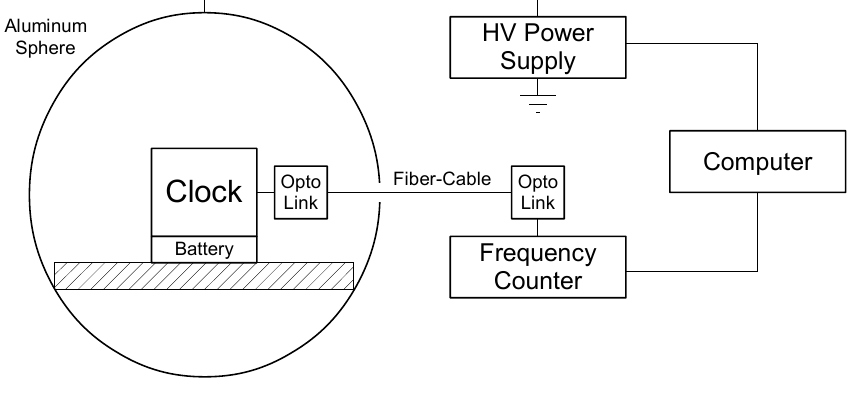
Figure 1. Experimental setup.